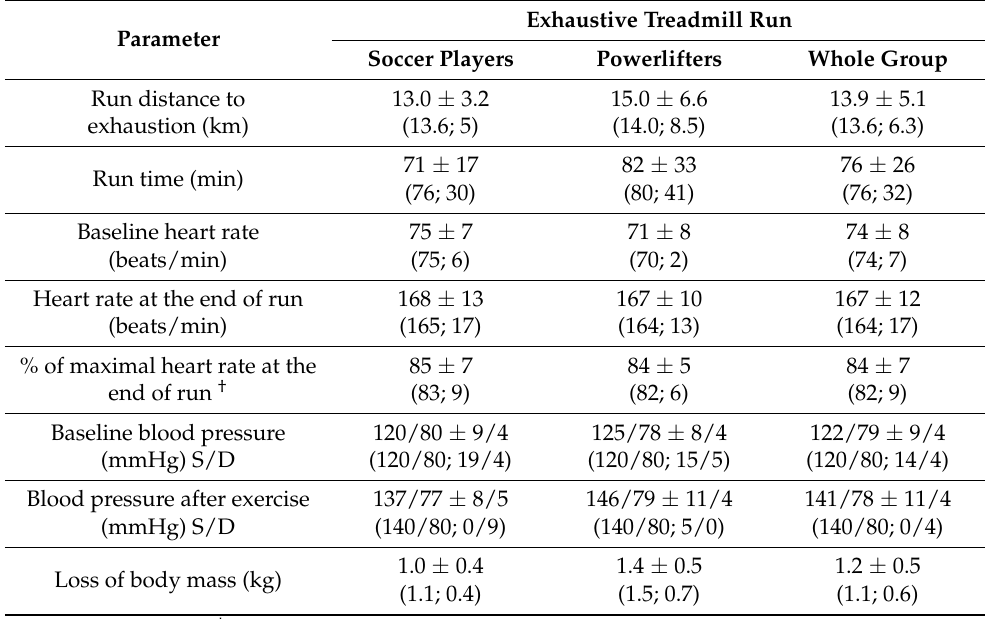
Table 3. Parameters monitored and calculated during the exhaustive treadmill